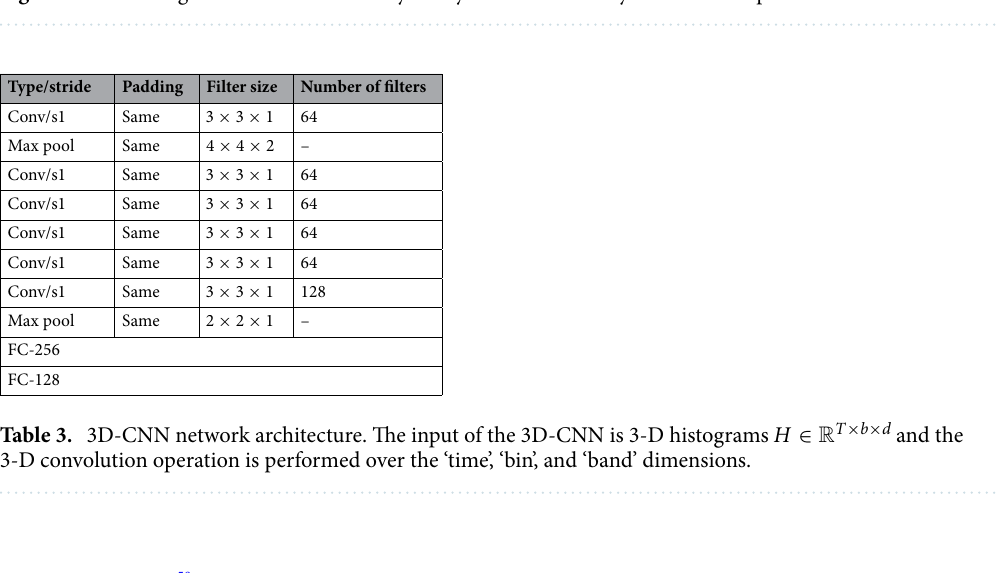
Figure 4. The histograms of the corn and soybean yields. The unit of yield is bushels per acre.